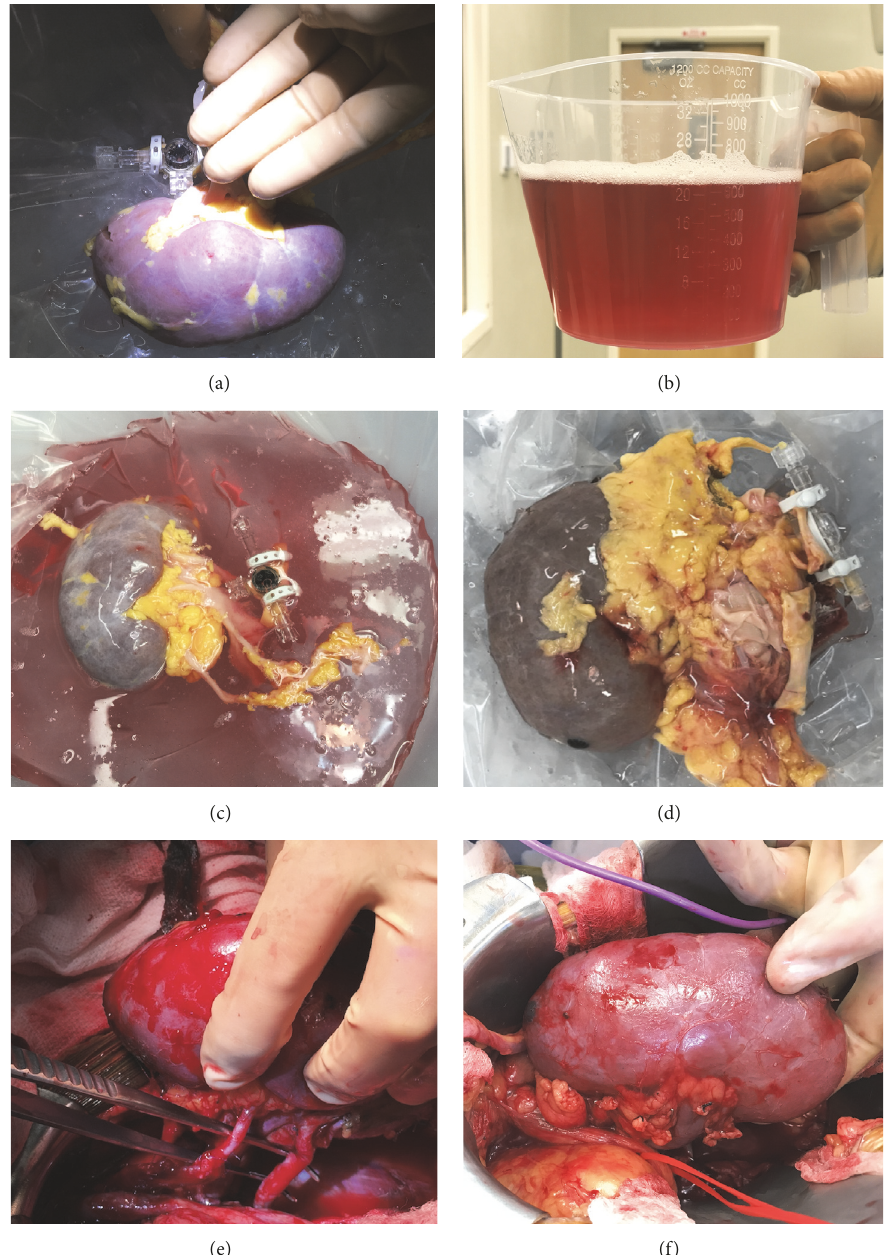
Figure 1: (a) Allograft #1 at time of procurement. (b) Discoloration of effluent. (c) Allograft #1 on pump. (d) Allograft #2 on pump. (e) Allograft #1 in vivo. (f) Allograft #2 in